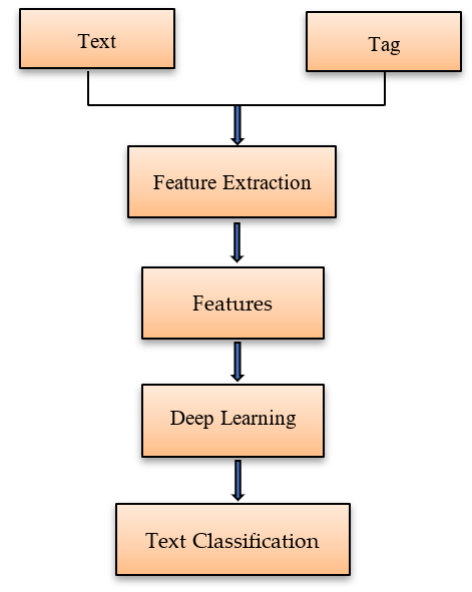
Figure 3. Steps involved in text classification.